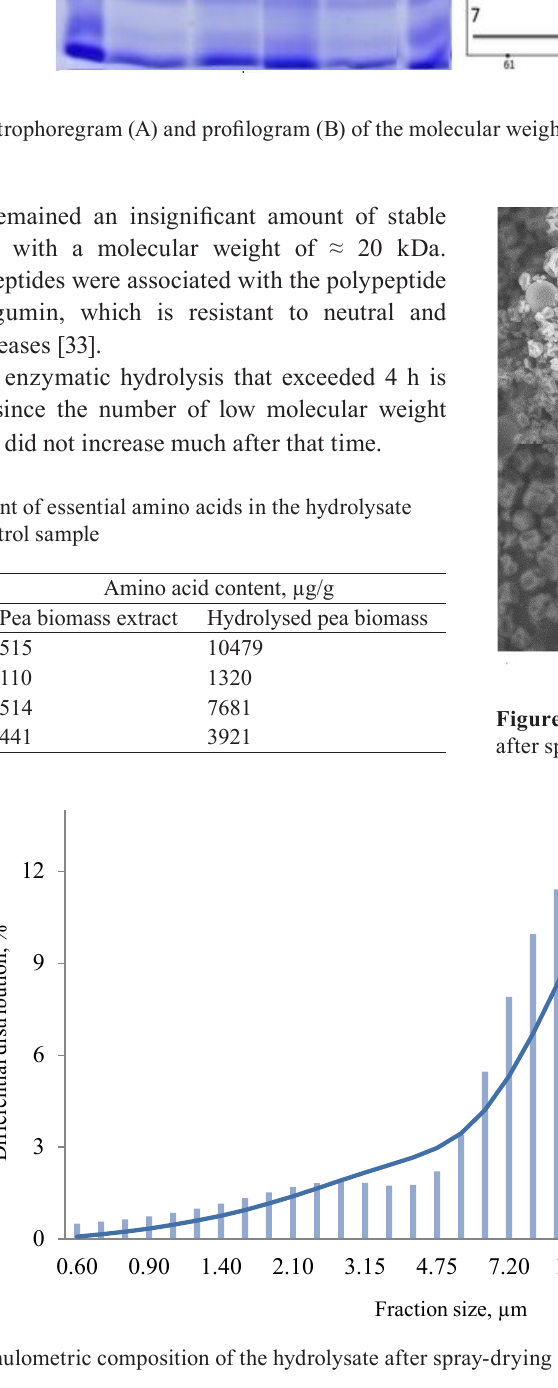
Figure 8 Granulometric composition of the hydrolysate after